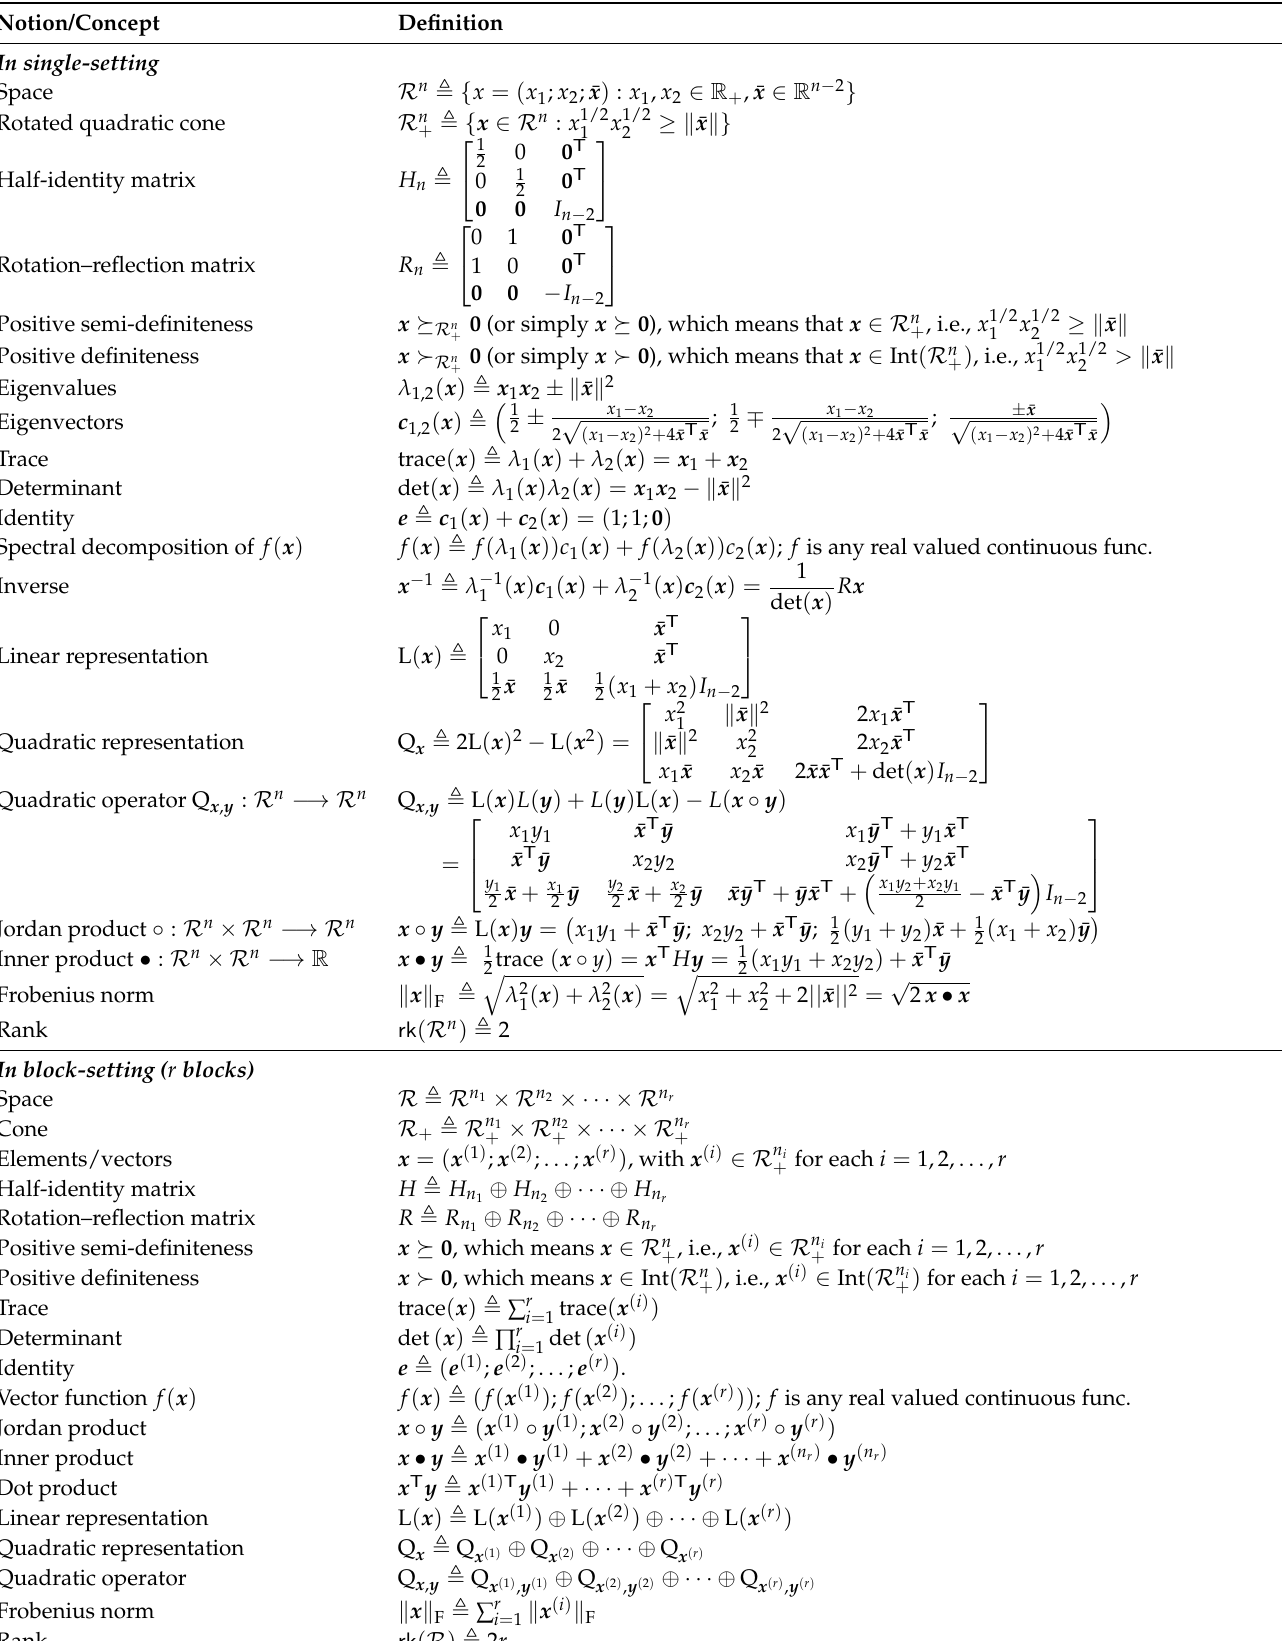
Table 1. The algebraic notions and concepts associated with R n + (for more details, refer to